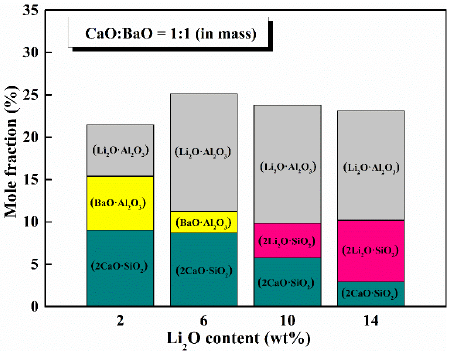
Figure 8. Effect of Li 2 O content on the activities of Al 2 O 3 and SiO 2 and the reactivity of mold flux.